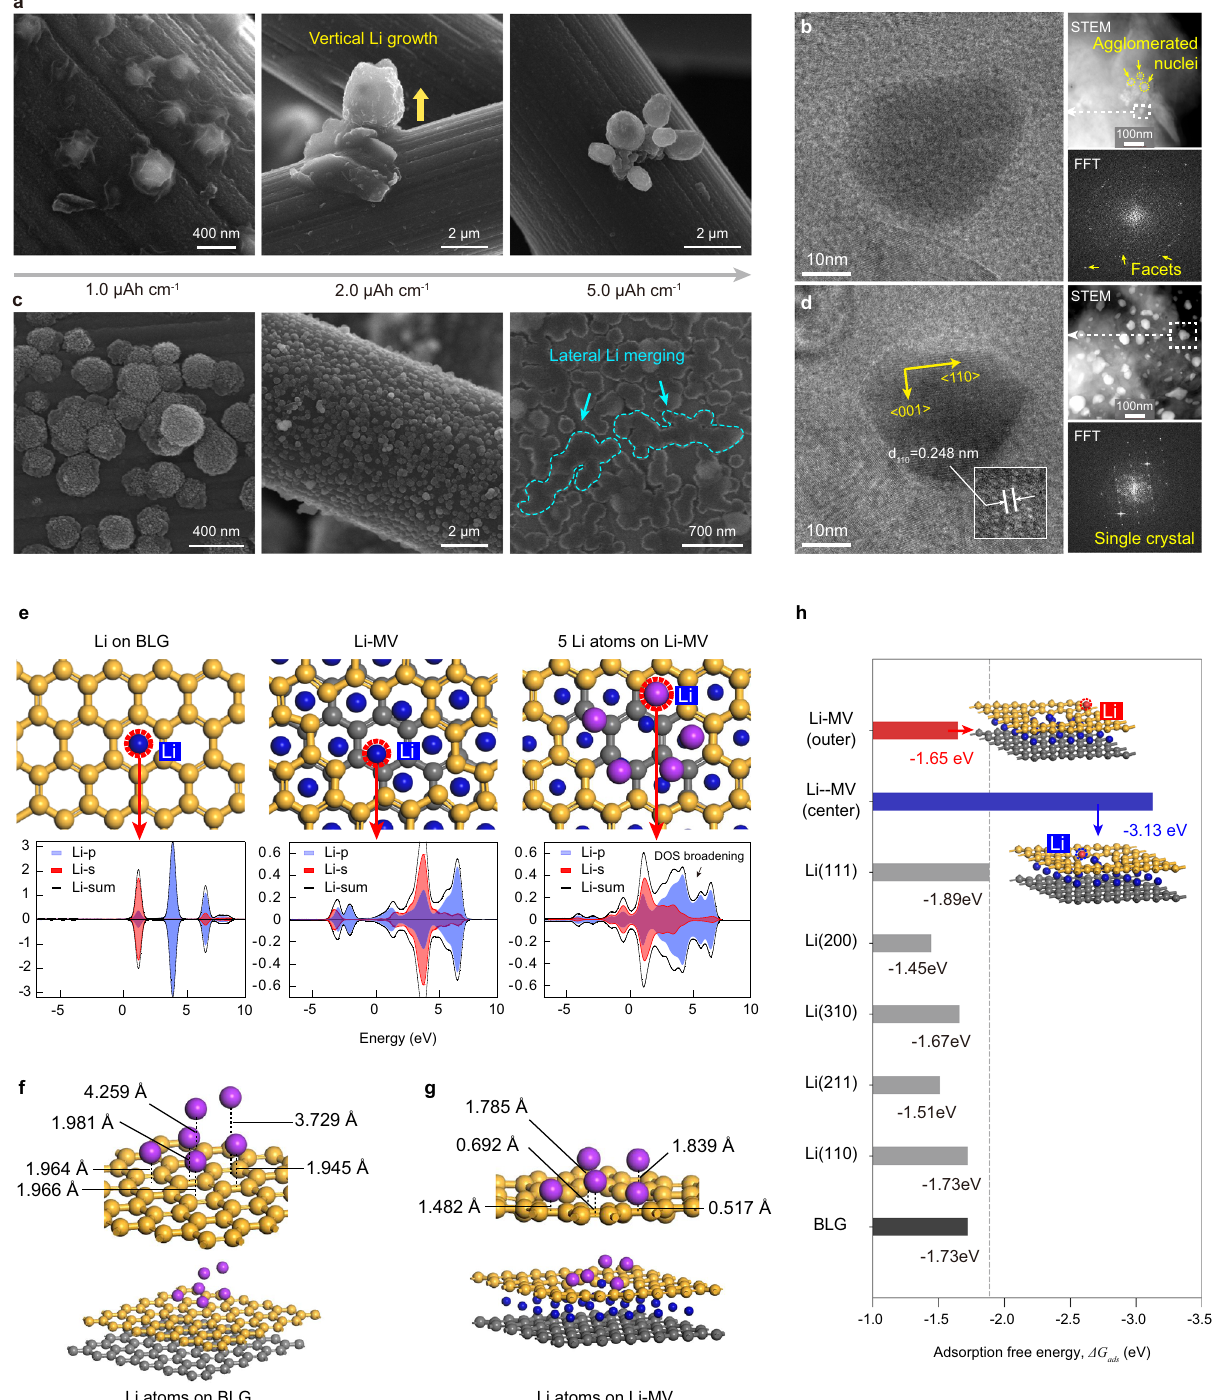
Fig. 5 Mechanistic analysis of the morphological propensity of Li nucleation and growth on MV defects. a SEM images of the Li deposit morphology on p-CP after Li deposition at 1.0 mA cm − 2 for 3.6, 7.2, and 18 s, which correspond to 1, 2, and 5 μ Ah cm − 2 , respectively. b TEM, STEM, and FFT images of Li nuclei on p-CP at 1.0 mA cm − 2 and 1 μ Ah cm − 2 . c SEM images of the Li deposit morphology on d-CP after Li deposition at 1.0 mA cm − 2 for 3.6, 7.2, and 18 s, which correspond to 1, 2, and 5 μ Ah cm − 2 , respectively. d TEM, STEM, and FFT images of Li nuclei on d-CP at 1.0 mA cm − 2 and 1 μ Ah cm − 2 . e Relaxed structures and pDOS results of a single Li atom adsorbed on perfect BLG, Li-MV, and Li-MV with four preadsorbed Li atoms. f , g Relaxed con fi gurations of Li atom clusters absorbed on perfect BLG and Li-MV (Li 3 C 8 ). The lithiated Li and Li clusters, carbon in the upper layer, and carbon in the lower layer are shown in blue, purple, yellow, and gray colors, respectively. h Adsorption free energies of Li atoms on the outer and center of Li-MV, various facets ((111), (200), (310), (211), (110)) of Li metal, and perfect